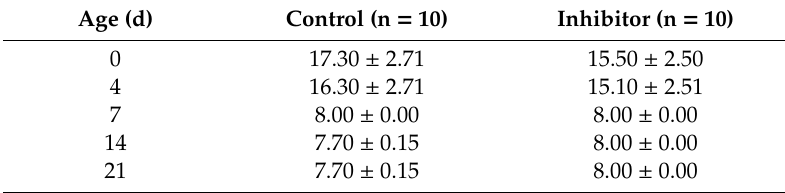
Table 5. E ff ects of GABA-T inhibitor treatment on litter size in female rats. Age (d) Control (n =